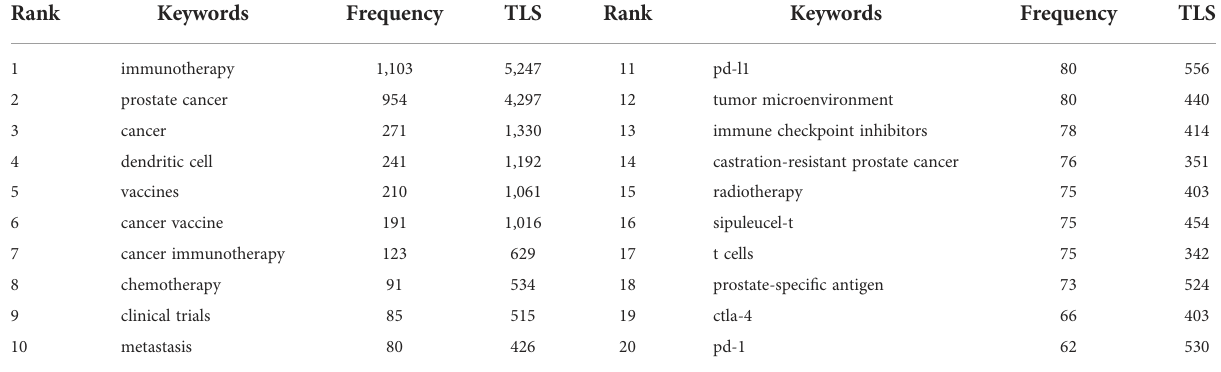
TABLE 5 Top 20 co-occurrence keywords involved in the research of PCa immunotherapy. Rank